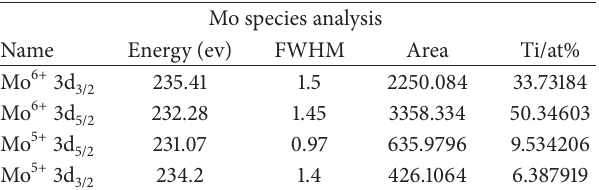
Table 2: The content of different Mo valence state. Mo species analysis